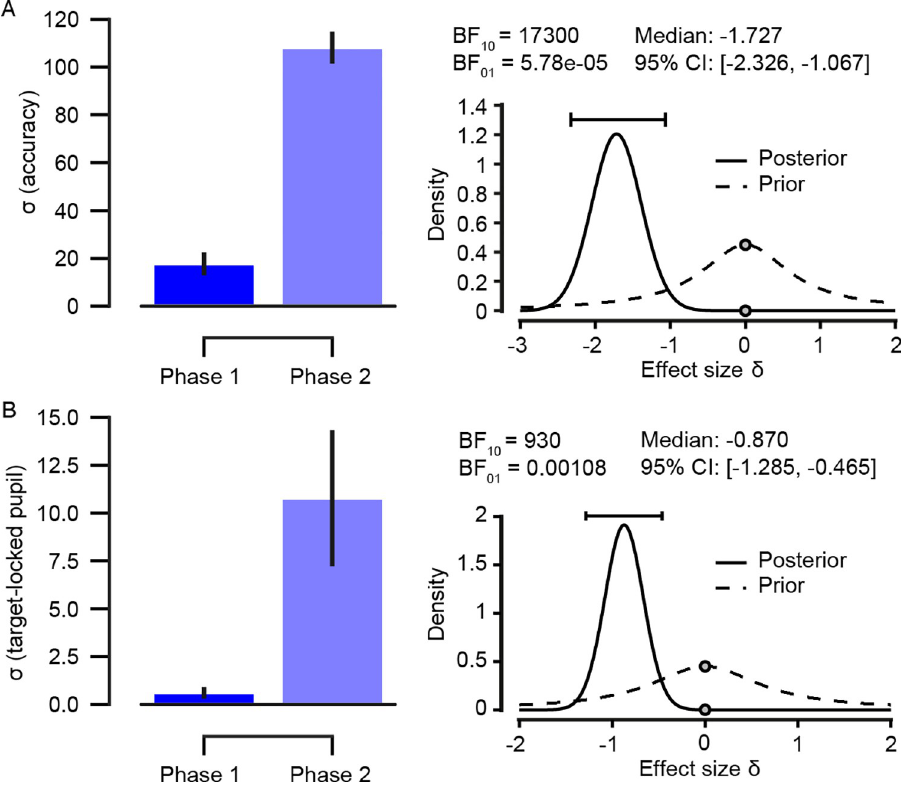
Fig 4. Comparisons of σ parameter of the curve fits on tone trials. For each participant, sigmoid curves were fit to the tone trials (i.e., trials with an auditory cue) and compared between the first and the second phase of the experiment. ( A) For accuracy data, all tone trials (i.e., the high- and low-frequency conditions) were used to fit the curves. ( B ) For the target-locked pupil response data, curves were fit to the high-frequency (80%) tone trials only. Note that the cue- target mappings (M1 and M2) which correspond to the high-frequency trials differ per phase depending on the presence of the auditory cue. Results of the Bayesian Wilcoxon Signed-Rank Test are shown for the accuracy and pupil data (right column). Error bars, s.e.m. ( N =